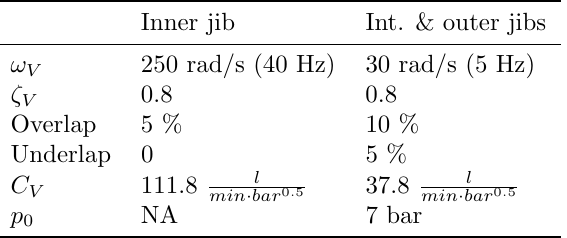
Table 4: DCV model